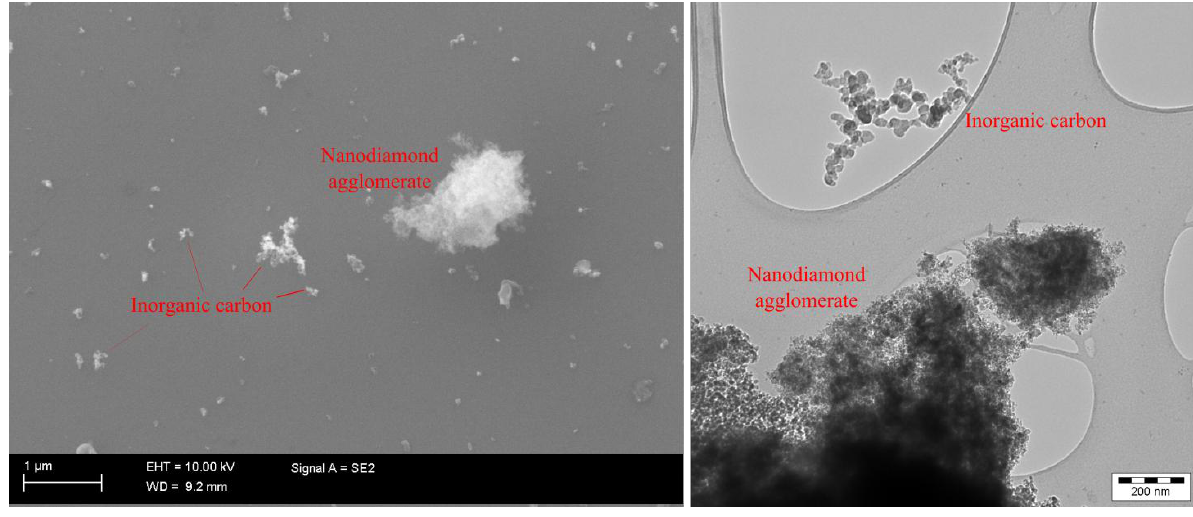
Figure 5. Scanning (left) and transmission (right) electron micrographs of particles sampled from the work station